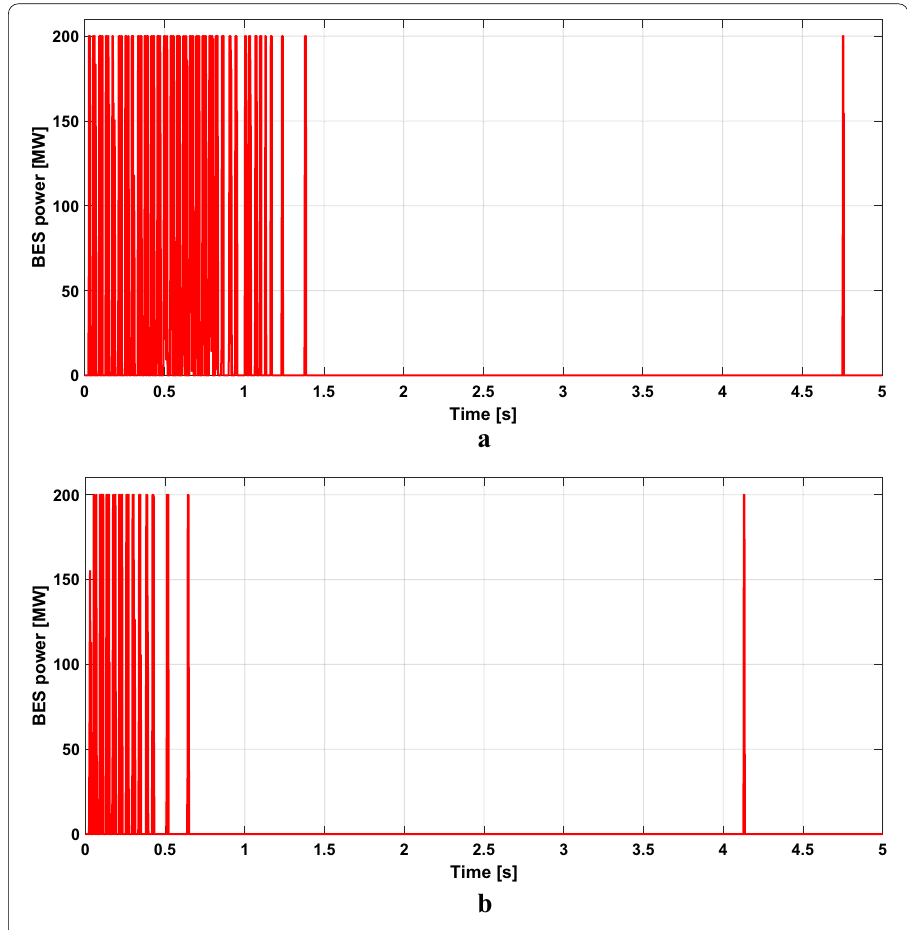
Fig. 9 BES real power responses in MW, a without TCBR, b with TCBR